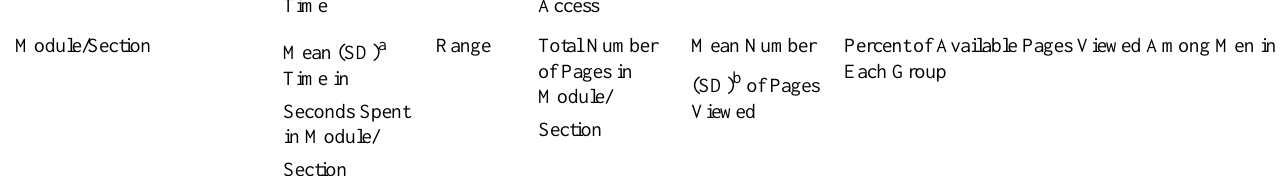
Table 2. A summary of participants’ use of Prosdex: mean time (seconds); mean number of pages viewed; percentage of available pages viewed and percentage of videos/animations viewed among men in the low, intermediate, and high access groups